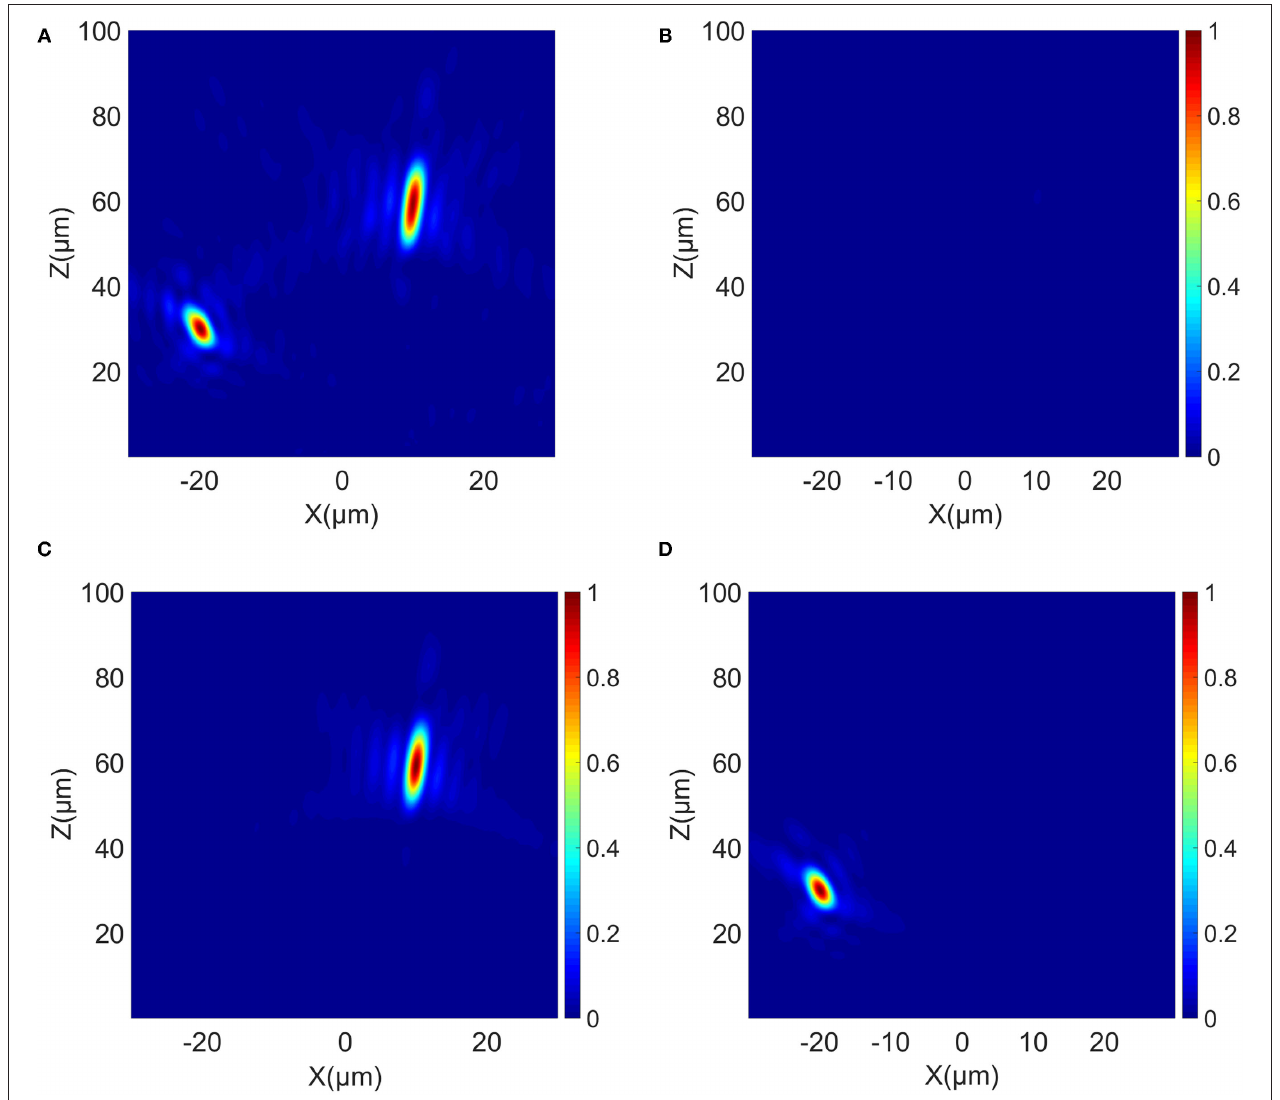
20,0,30 ) , f ′ B ( 10,0,60 ) . (A) For x-polarized incident light in the −